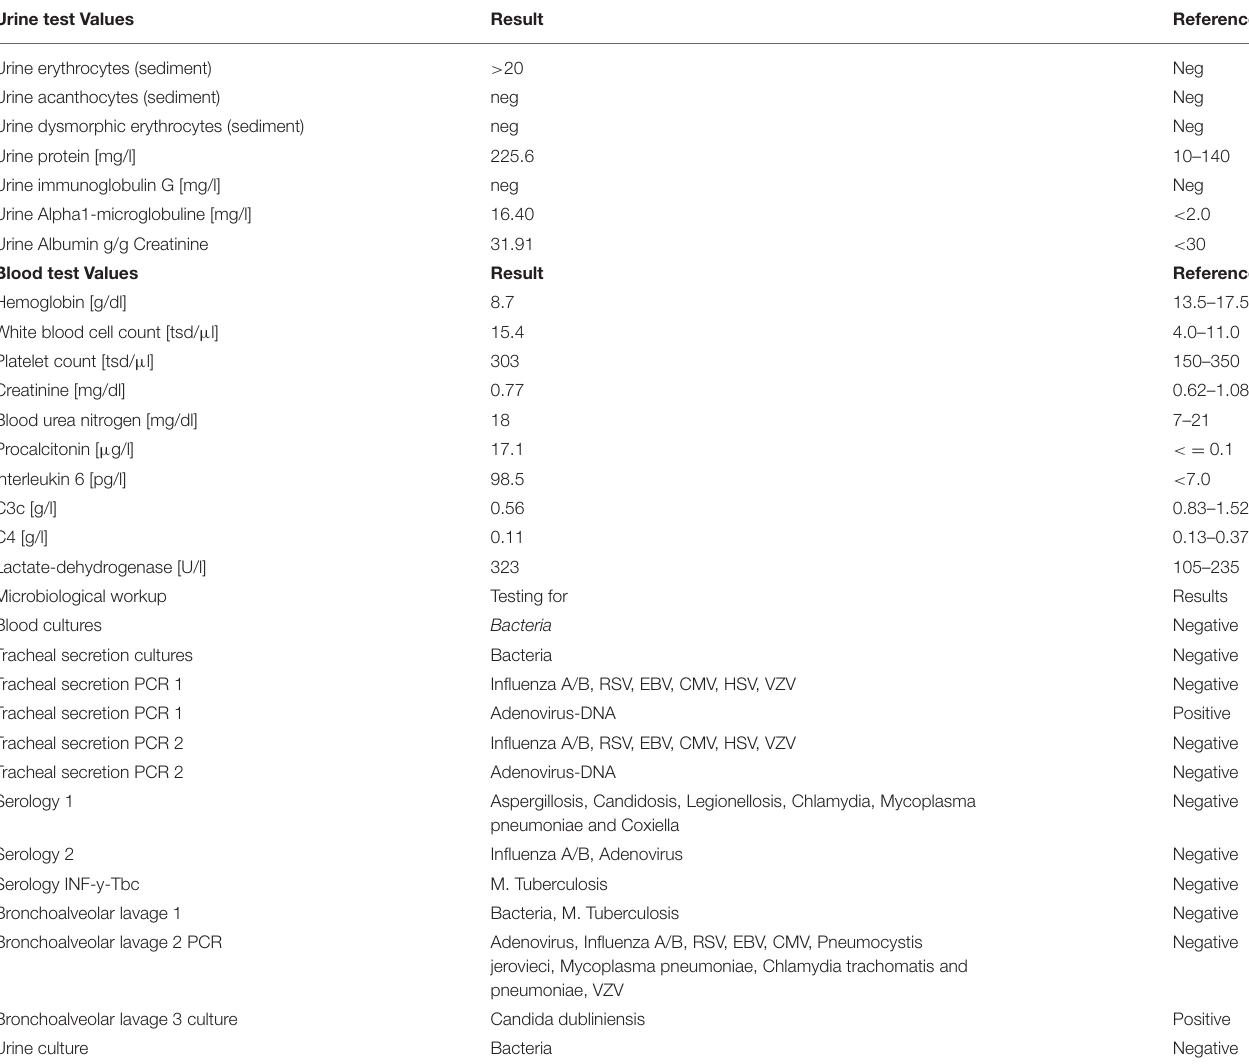
TABLE 1 | Urine analysis, laboratory tests and microbiological diagnostic workup on